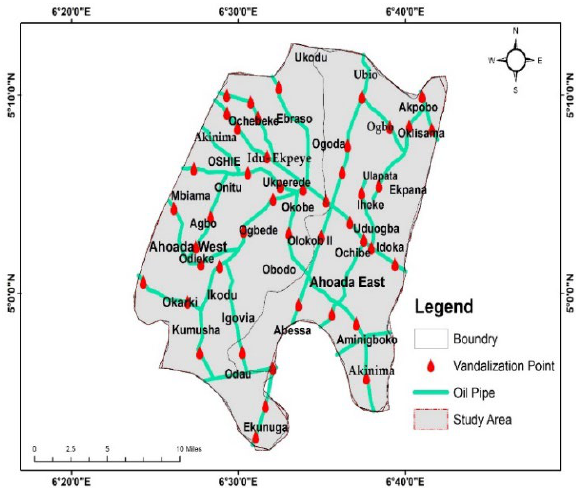
Figure 3. Map of Ahoada with pipelines and vandalization